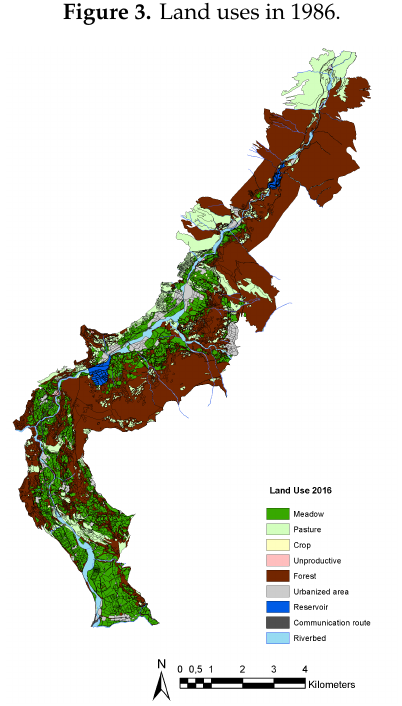
Figure 4. Land uses in